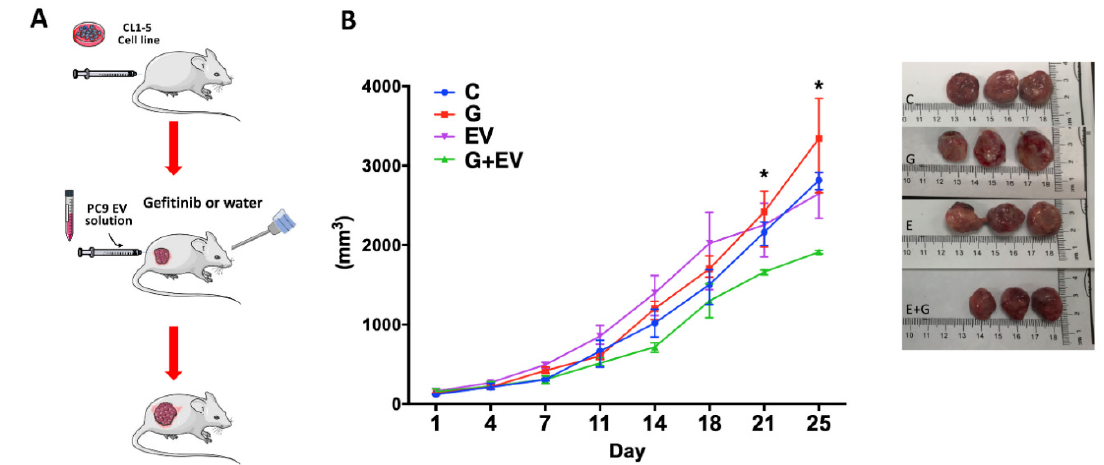
Figure 4. EVs derived from EGFR-mutant cells delayed EGFR wild-type tumor growth in vivo. ( A ) A schematic diagram illustrating the design of the animal model. ( B ) Dynamic tumor growth and treatment responses to (C) control, (G) gefitinib (50 mg/kg/day), (EVs) extracellular vesicles (20 µ g, intratumor injection twice per week), and (G+EVs) gefitinib + extracellular vesicles (* p <